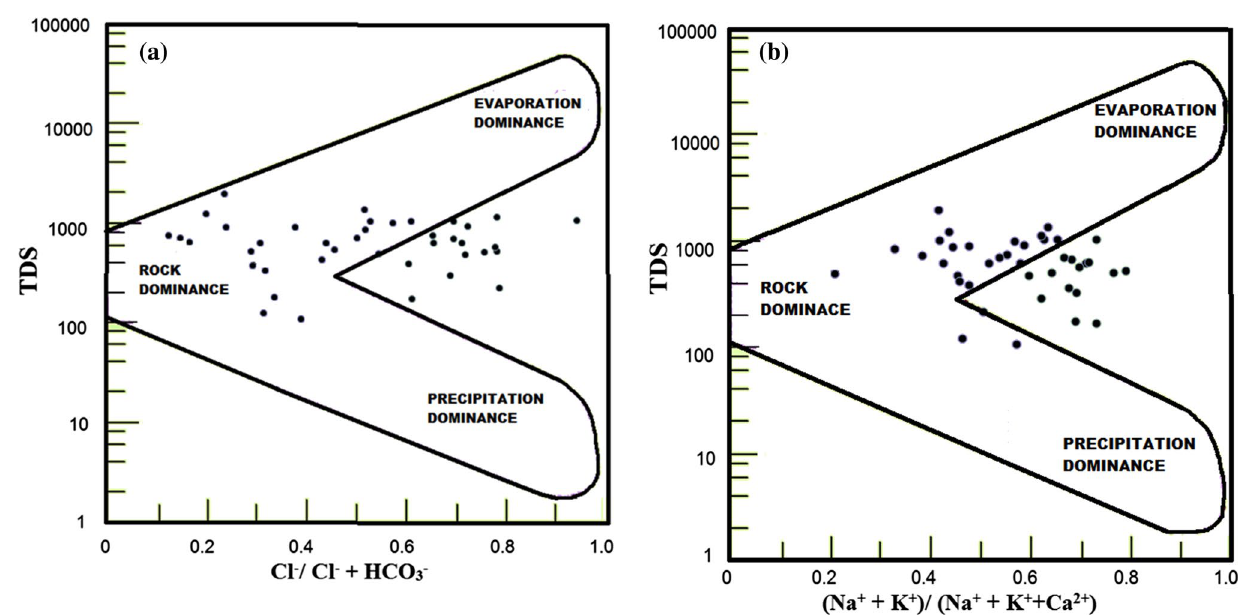
Fig. 8 Mechanism controlling of groundwater chemistry plots (Gibbs 1970) a Cl − /Cl − + HCO 3− b (Na + + K + )/(N + + K + + Ca 2+